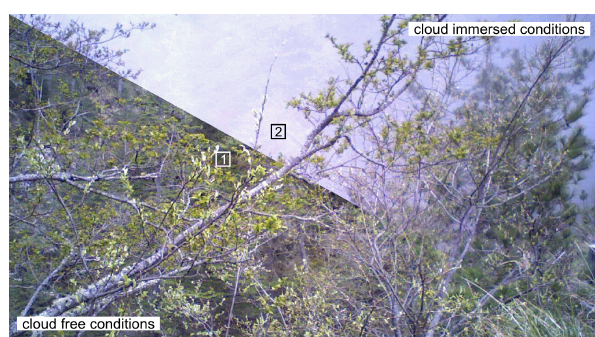
Figure 11. Image of the validation cam under cloudy and cloud-free conditions. c v max is 0.230 for the 30 × 30 pixels box denoted “1” and 0.020 for the box denoted “2” (see text for further